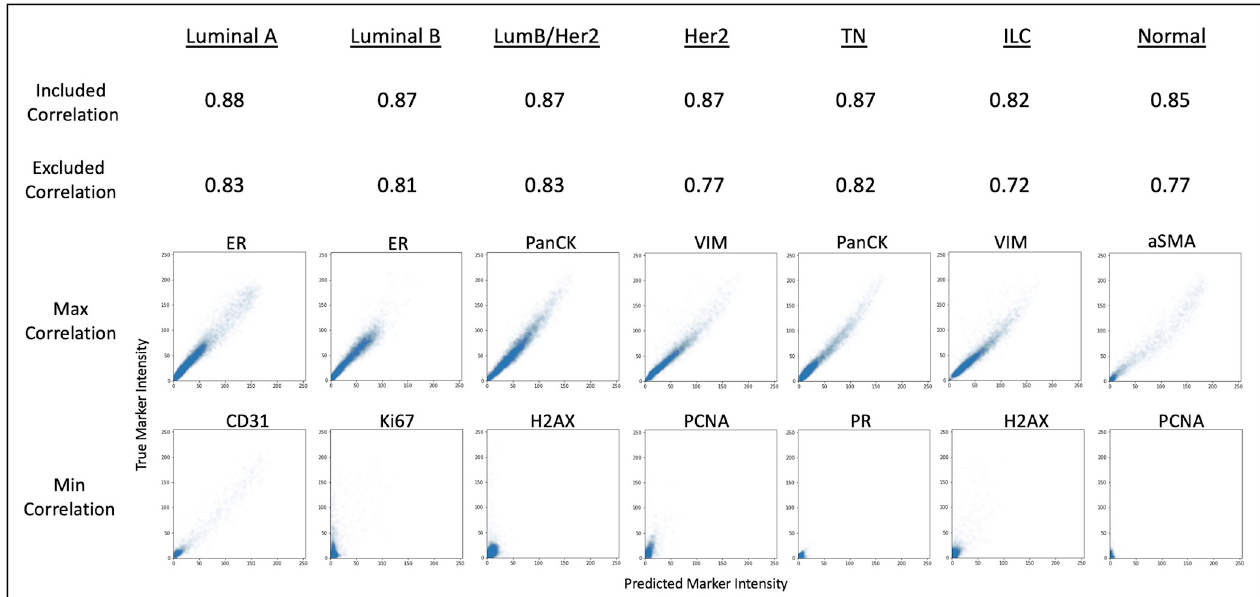
Fig 4. The full panels of six different breast cancer subtypes and normal were predicted using the highest performing reduced panel (correlation-based selection with 18 markers). Spearman correlations were calculated between the full panel expressions and the expressions of the predicted markers for the included markers and excluded markers separately. The expression correlation plots for the best and worst predicted markers are shown for each subtype.